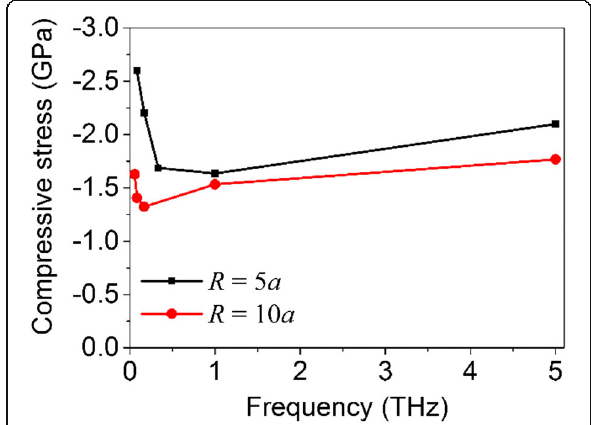
Fig. 13 Final compressive stress as a function of vibration frequency for the sintered